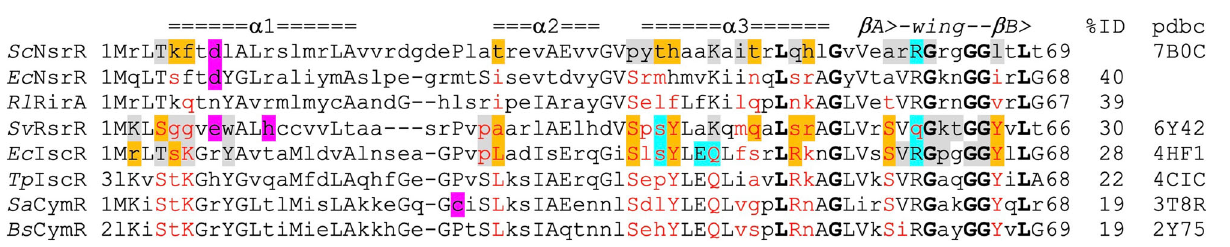
Fig. 4 Comparison of [4Fe-4S]- Sc NsrR/ hmpA1 complex with DNA-free structures. a Structural superposition of the complex to [4Fe-4S]- Sc NsrR (green, cluster not shown). b Superposition to apo-3CA- Sc NsrR (gray). The complex is colored as in Fig. 1 and selected amino acid residues are highlighted. Red arrows indicate movements observed for residues 87, 93 and 99. Regions of the apo structure that would collide with hmpA1 are indicated by red asterisks. Atom color codes are as in Fig. 3. Rotated stereo zooms of the same superpositions are given in Fig. S6 and S8.